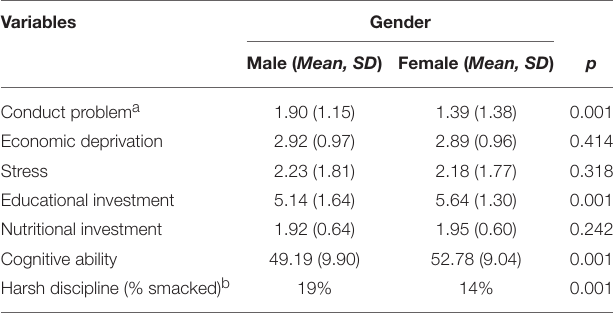
TABLE 2 | Gender differences on predictor, mediator and outcome